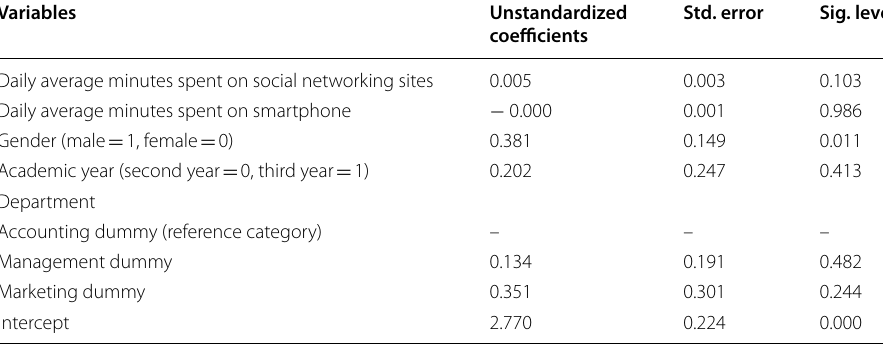
Model summary: Number of observations